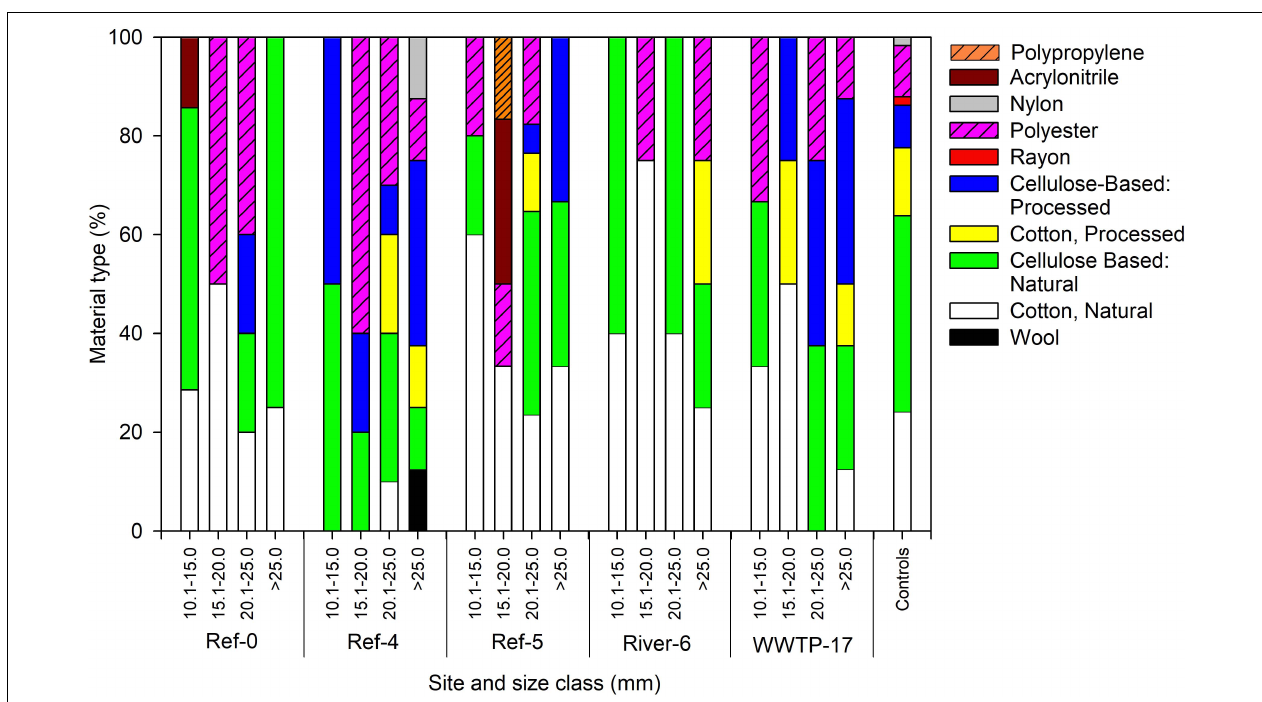
FIGURE 6 | Relative abundance of microplastic particles by polymer type in dreissenid mussels collected from Milwaukee Harbor in July 2018 for mussels at 5 sites across size classes. Ref, reference; WWTP, wastewater treatment plant. The smallest class (5–10 mm) was not sampled due to low particle count.